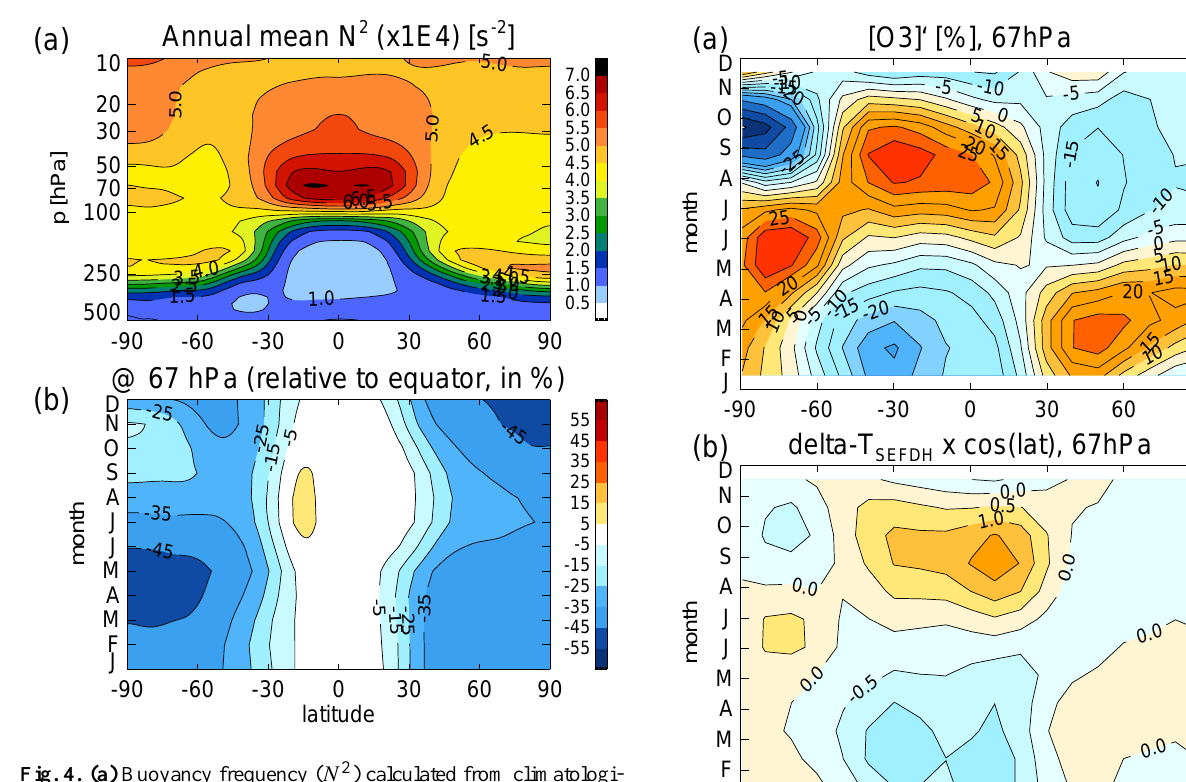
Fig. 4. (a) Buoyancy frequency ( N 2 ) calculated from climatologi- cal annual mean, zonal mean temperatures. (b) Ratio of N 2 (φ) (cal- culated from climatological monthly mean data) to value at equator (N 2 (φ = 0 ) ), expressed in percent.